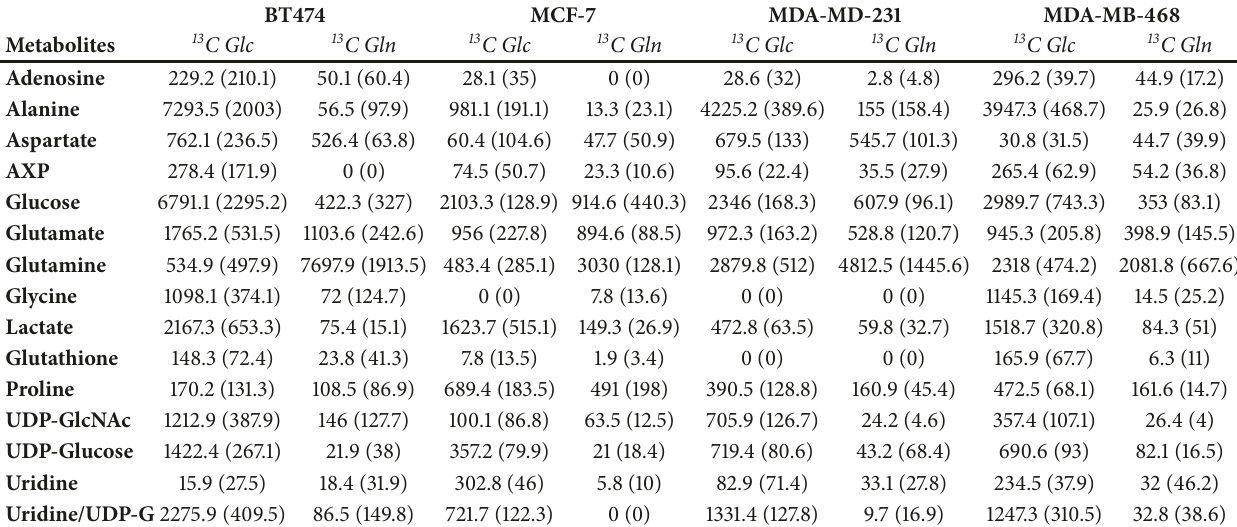
Table 1: Semiquantitative concentrations of intracellular metabolites ∗